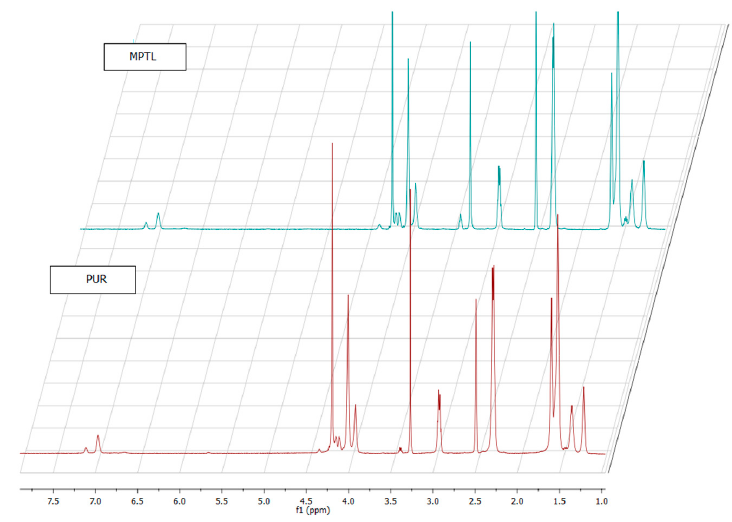
Figure 3. 1 HNMR spectra of obtained PUR and MPTL scaffolds. Table 2. Chemical shifts assignments of 1HNMR analysis presented in Figure 3.